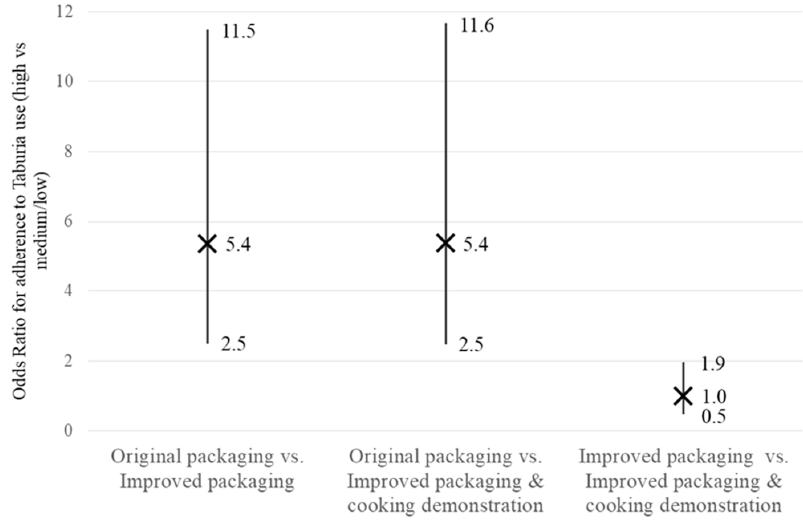
Figure 4. Adherence to prescribed use of Taburia 30 days after distribution among children who consumed Taburia without sharing. Adherence was defined as “high” (13–17 sachets), “medium” (8– 12 or 18–22 sachets) or “low” ( ≤ 7 or ≥ 23 sachets). ( a ) Group 1: Original outer packaging, as regulated by the MoH; ( b ) Group 2: Improved design and messages content of outer packaging; and ( c ) Group 3: Improved outer packaging combined with cooking demonstrations. Differences between groups are statistically different ( p < 0.001) using multinomial distribution via Cumulative Logit function. Values with different superscript letters are significantly different using Wald’s Chi-square adjusted for multiple comparisons (least significant difference) post-hoc analysis ( p -value < 0.05).